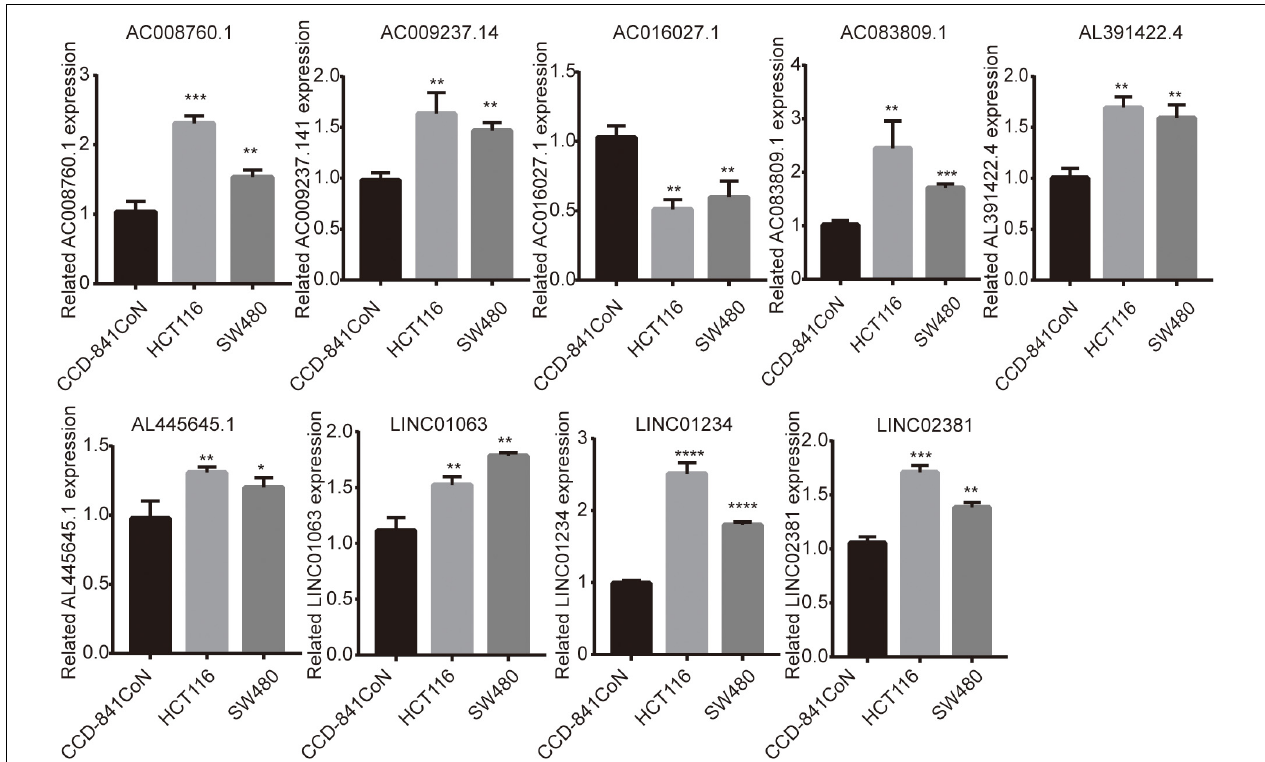
FIGURE 9 | Expression of nine lncRNAs in colon cancer cell lines and colon cell lines. Expression levels of nine lncRNAs in colon cancer cell lines (HCT116 and SW480) significantly differed from those in colon cell lines (CCD-841CoN). AC008760.1, AC009237.14, AC083809.1, AL391422.4, AL445645.1, LINC01063, LINC01234, and LINC02381 were highly expressed in HCT116 and SW480. AC016027.1 was lowly expressed in HCT116 and SW480. * p < 0.05, ** p < 0.01, *** p < 0.001, **** p <